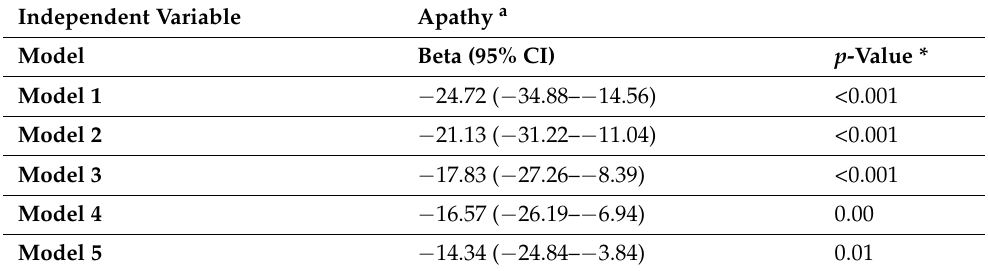
Table 3. Linear regression of association between apathy and gait velocity N = 347.